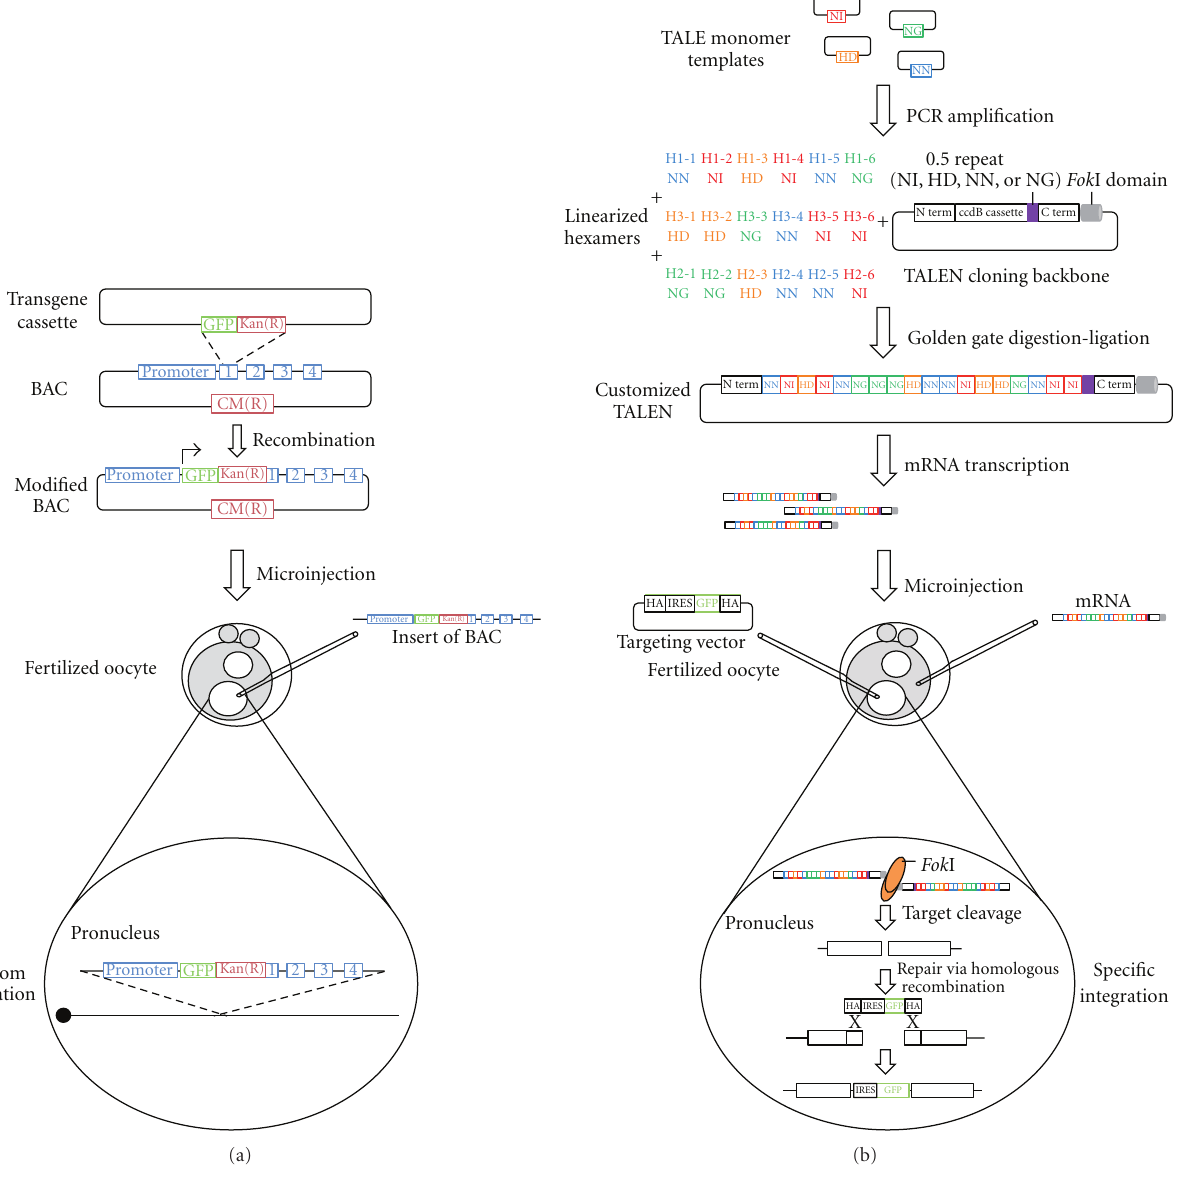
Figure 1: Genomic modifications through BACs and TALEN. (a) The recombination of the BAC and a transgene (GFP and the antibiotic resistance gene kanamycin) leads to a modified BAC which is then randomly integrated into the DNA after microinjection into the male pronucleus. (b) The customized TALEN, specific to the sequence of interest, is constructed by PCR and digestion-ligation of hexamers that are cloned into the TALEN backbone. Subsequently, the TALEN is transcripted into RNA followed by the microinjection of the RNA into the cytoplasm of the zygote simultaneous to the injection of the GFP containing targeting vector into the pronucleus. This results in specific integration of the GFP via homologous recombination generating a knock-in